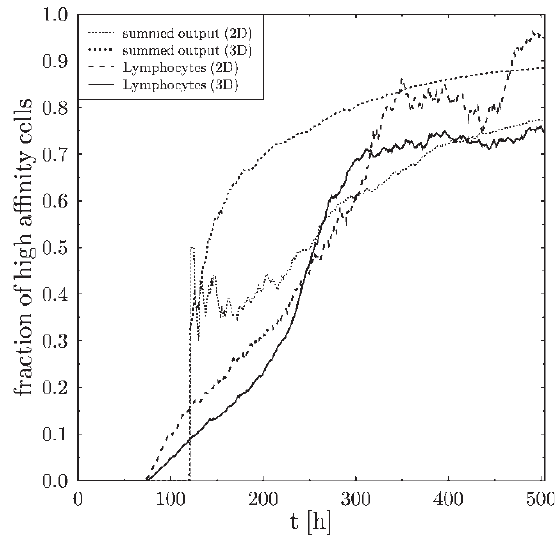
FIGURE 5 Affinity maturation: the four phases of the affinity maturation process are even more clearly seen in 3D simulations compared to 2D. Note that the summed total production of plasma and memory cells is of substantially higher quality in 3D than in 2D. Statistical fluctuations seen in 2D simulations are smoothened in